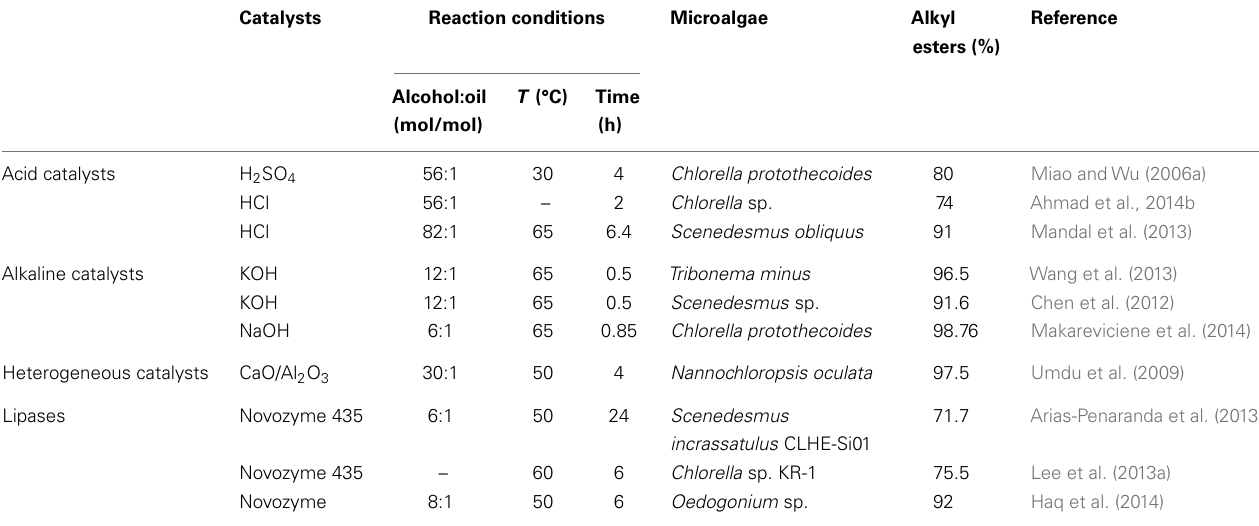
Table 5 | Comparison of different catalysts for direct transesterification of microalgae biomass